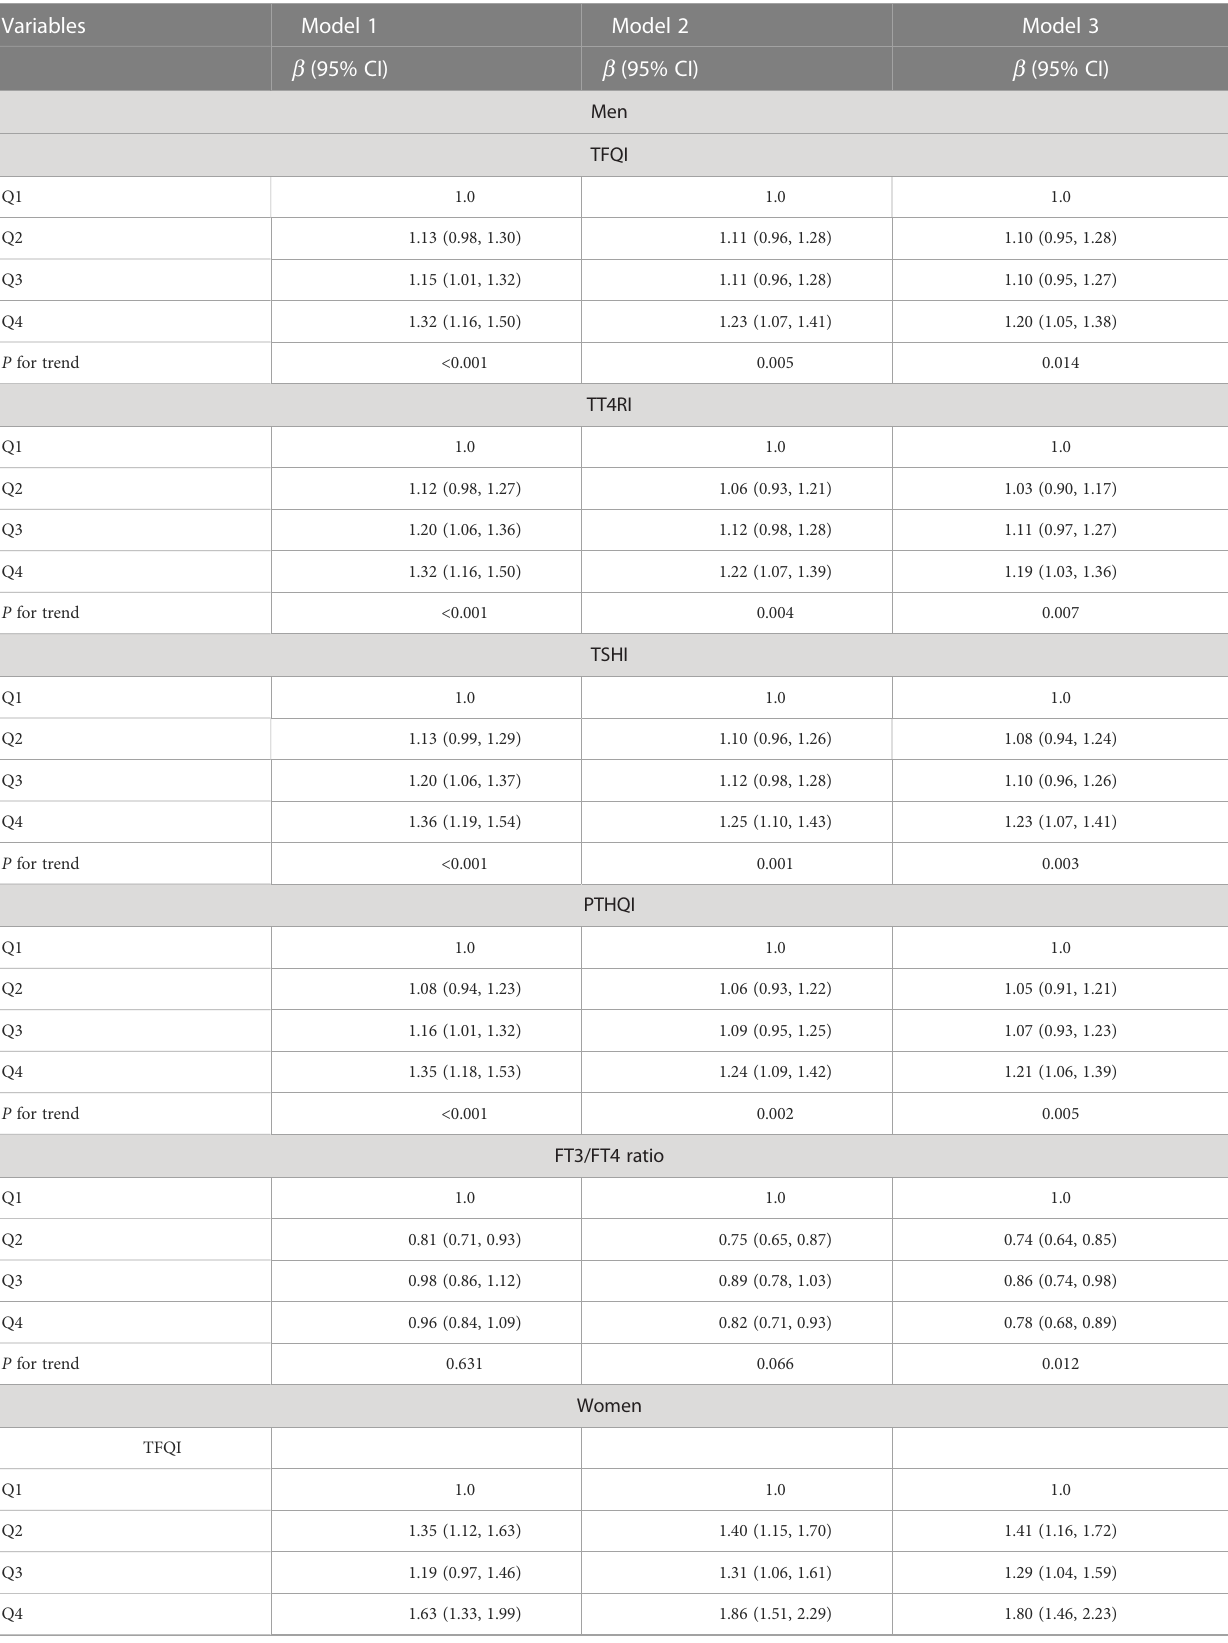
TABLE 4 Logistical regression analysis for the association between thyroid hormone sensitivity quartiles and HUA in a euthyroid